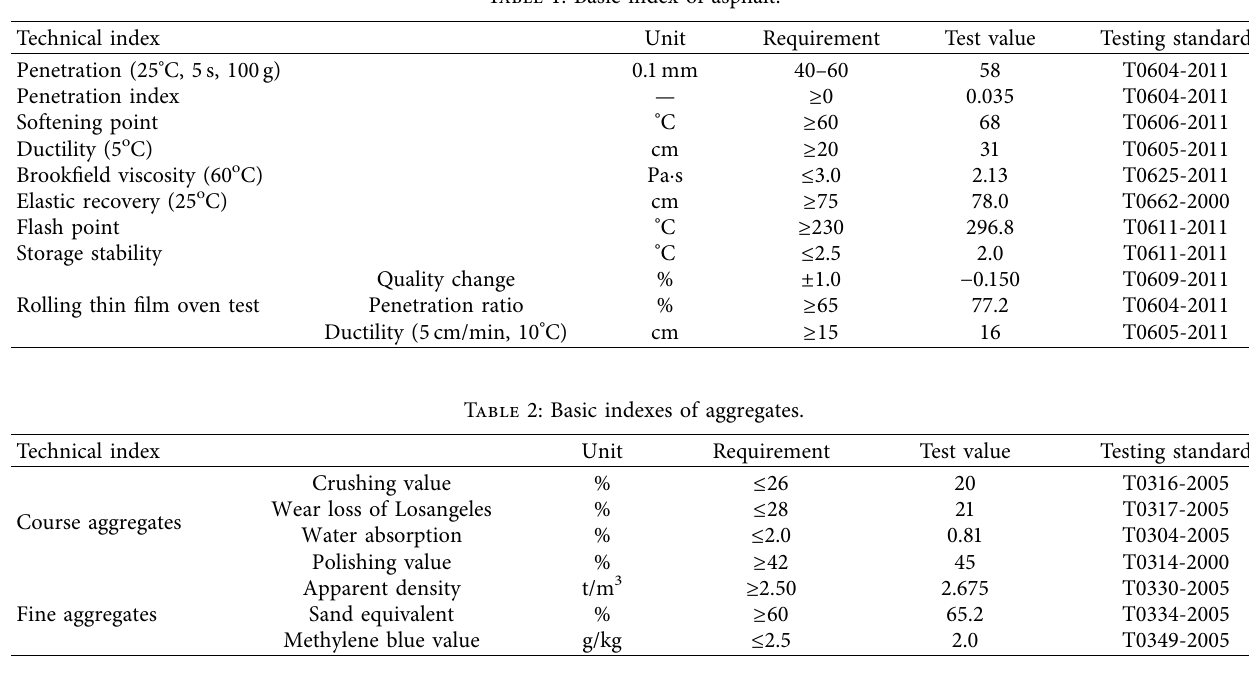
Table 1: Basic index of asphalt.